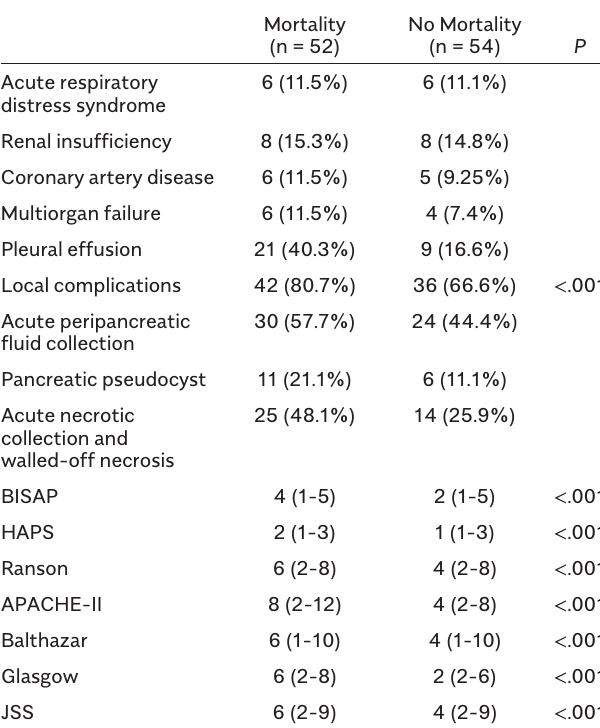
Table 3. Differences Between Patients Aged 80 Years and Older with and Without Mortality